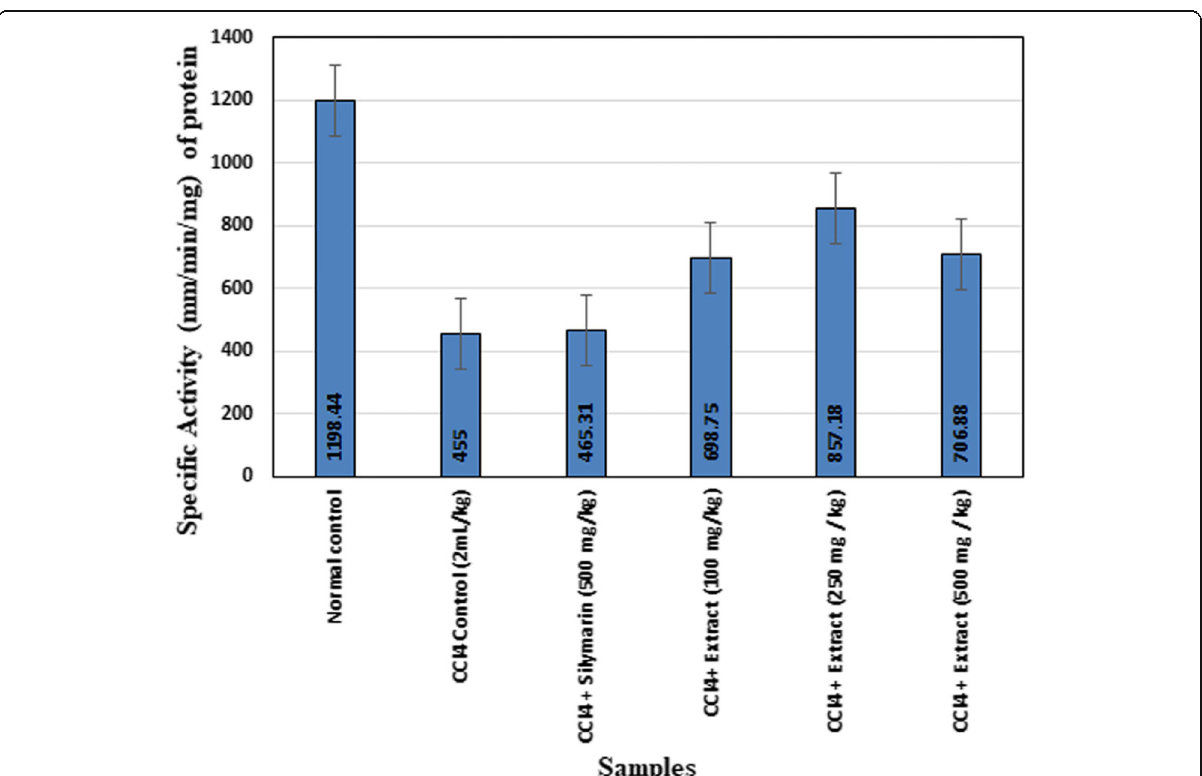
Fig. 1 Antioxidant enzyme (catalase) level in CCl 4 -induced liver